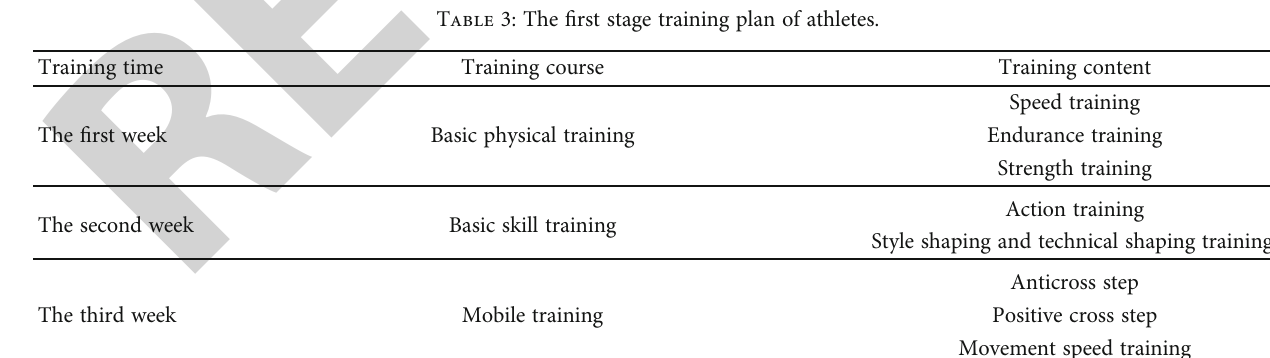
Table 3: The fi rst stage training plan of